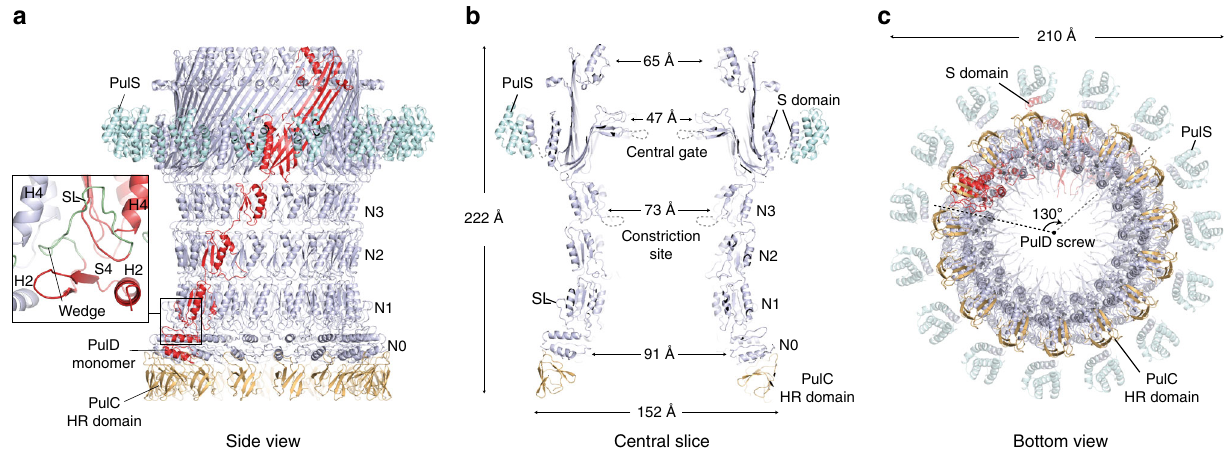
Fig. 3 Structure of the outer membrane complex (OMC). a Cartoon representation of the OMC, which includes the C15 symmetrized secretin (light blue) with a single PulD monomer highlighted in red. PulS (cyan) and PulC HR domain (orange) homology models were fi tted as rigid bodies. A total of 15 PulC HR domains were modelled here although stoichiometry measurements indicate an occupancy of ~0.8 in the Pul CDELMNS complex. Zoom panel shows how loop 7 (green coil) constitutes a stabilising loop (SL) that packs as a wedge between neighbouring N1 domains. b Cross section view of the OMC structure with dimensions. c Bottom view of the OMC structure. Each PulD monomer has an azimuthal span twisting around the secretin long axis of pilotin in complex with the PulD S-domain helix 15 based on the